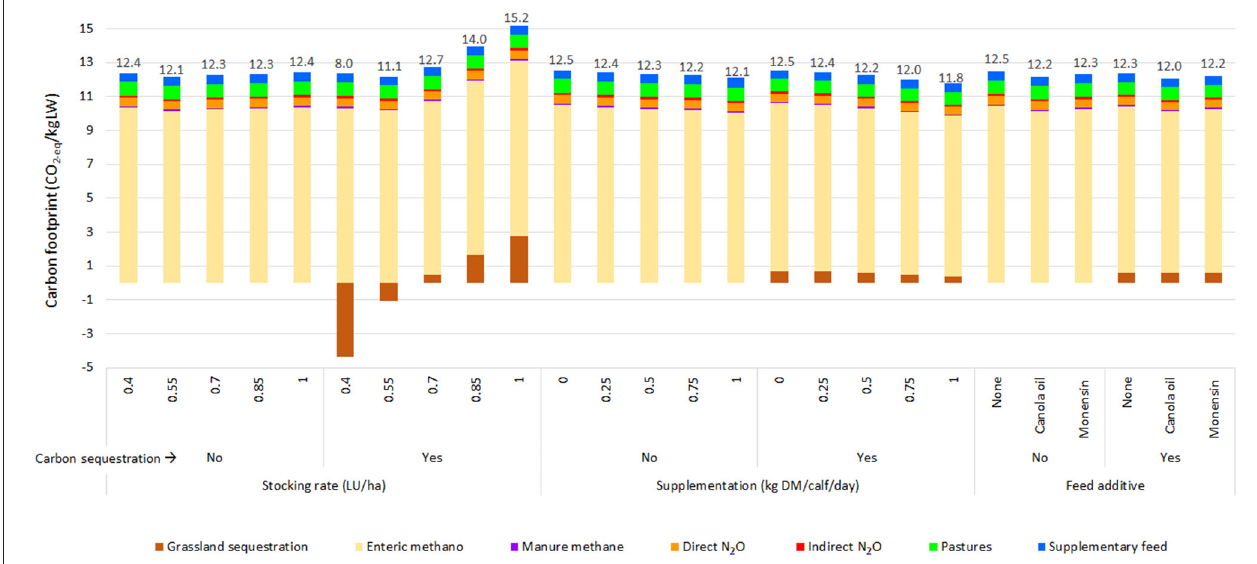
FIGURE 6 | Carbon footprint (CF) and distribution of greenhouse gas (GHG) emissions in simulated